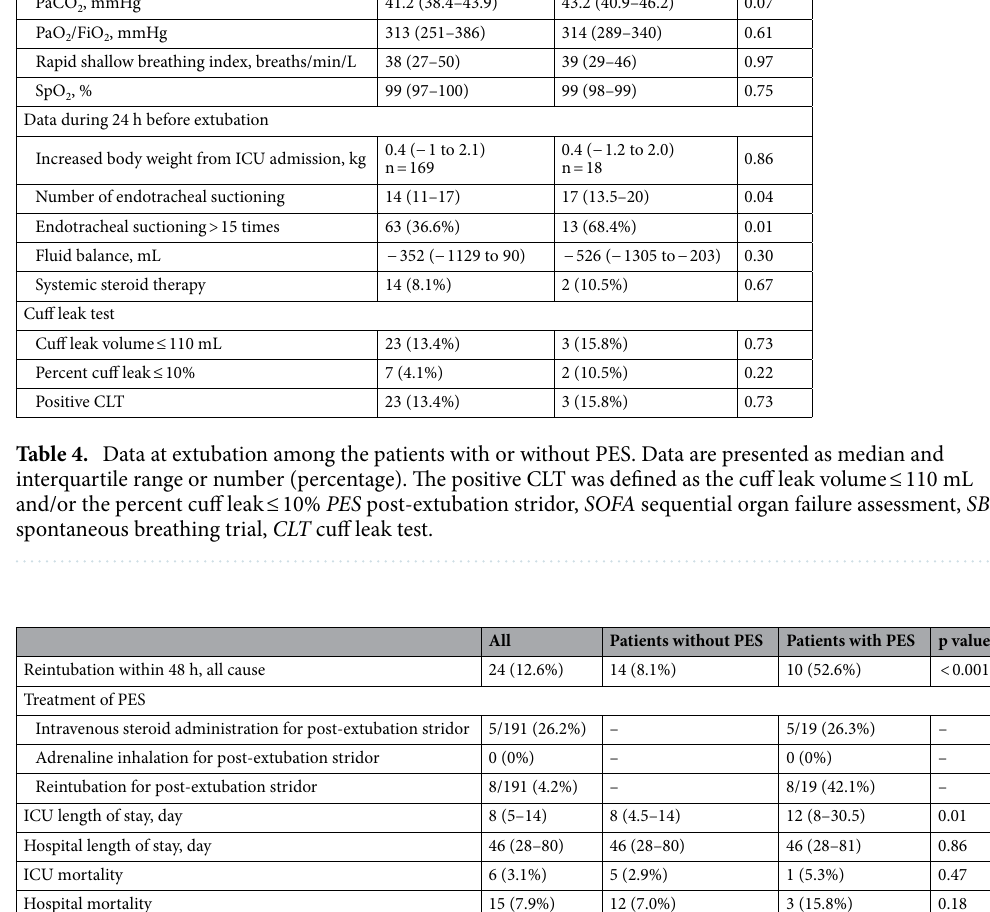
Table 5. Post-extubation outcomes of patients with and without PES. Data are presented as median and interquartile range or number (percentage). PES post-extubation stridor, ICU intensive care unit.